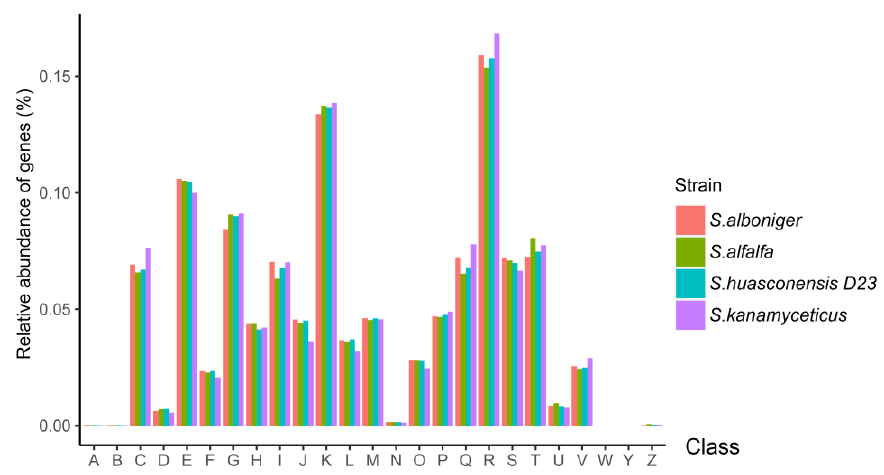
Figure 6. The cluster of Orthologous Groups (COG) database annotation of strain D23. The relative abundance of proteins (%) in the genome is shown. Letter codes are described in Table S2.